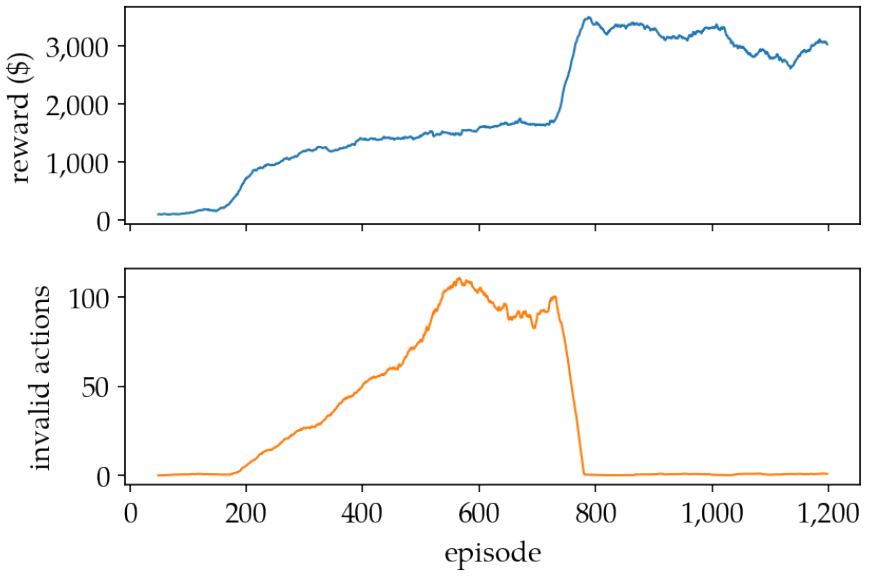
Figure 10. Training curves of the best run of the proposed model, averaged over a moving window of 50